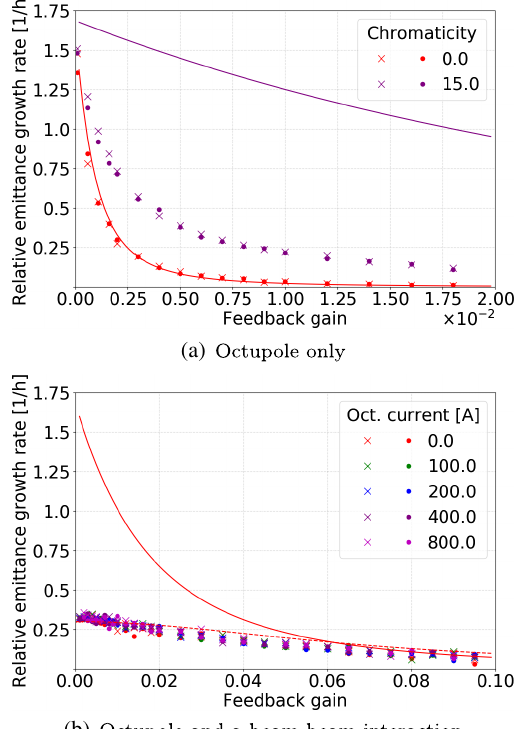
FIG. 3. Relative emittance growth rate as a function of the feedback gain in the presence of linear amplitude detuning generated by octupoles. The octupoles are powered with 500 A (upper plot), generating a direct amplitude detuning term of 7 . 75 × 10 − 5 m − 1 and an indirect term of 5 . 44 × 10 − 5 m − 1 [19]. The lines represent prediction based on Eq. (1) with a tune spread given by the quadratic sum of the detuning arising from the octupole and the chromatic detuning. The lower plot shows as similar configuration featuring a single IP, for different powering of the octupoles. The LHC powering is limited to 570 A. The solid line shows the prediction of Eq. (1) whereas the dashed line corresponds to Eq. (2). The parameters for the numerical simulations are listed in Table I. The crosses and dots correspond to the result for the horizontal and vertical planes